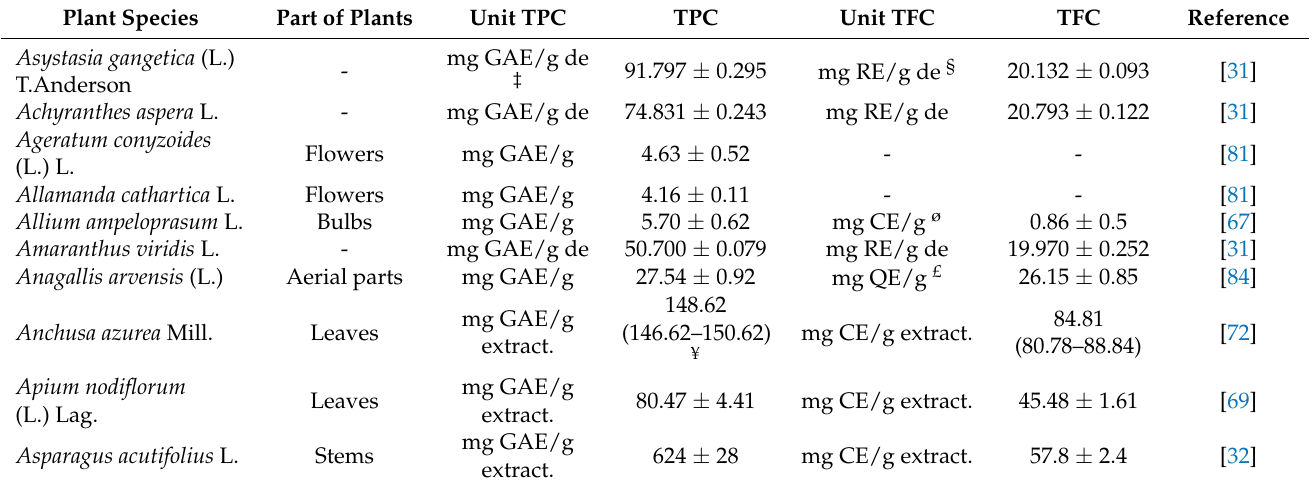
Table 4. Total phenolic content (TPC) and total flavonoids content (TFC) in wild edible